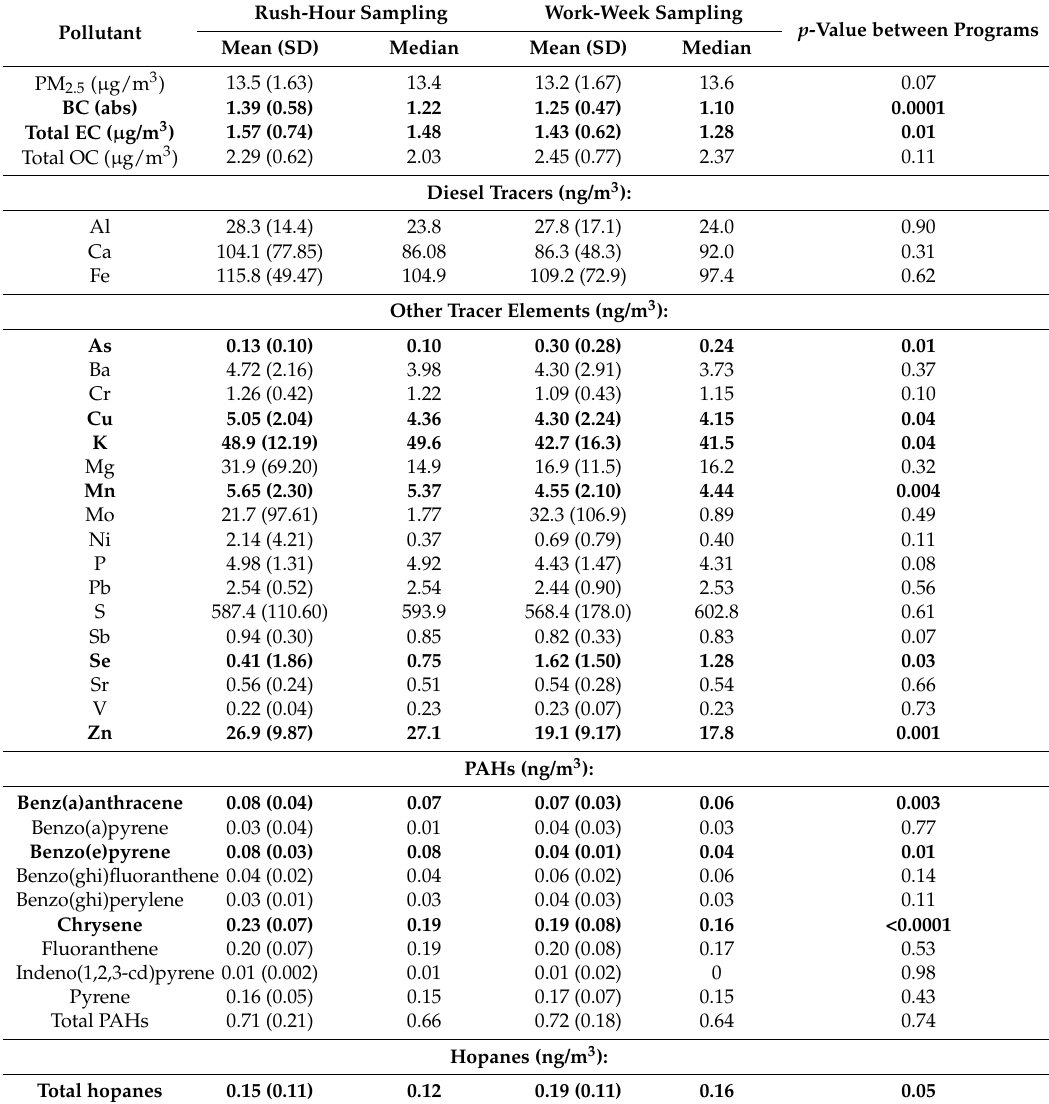
Table 1. Temporally-adjusted winter pollutant concentrations across 24 distributed sites, by sampling interval. Concentrations which differed significantly between sampling schemes are shown in bold ( p <